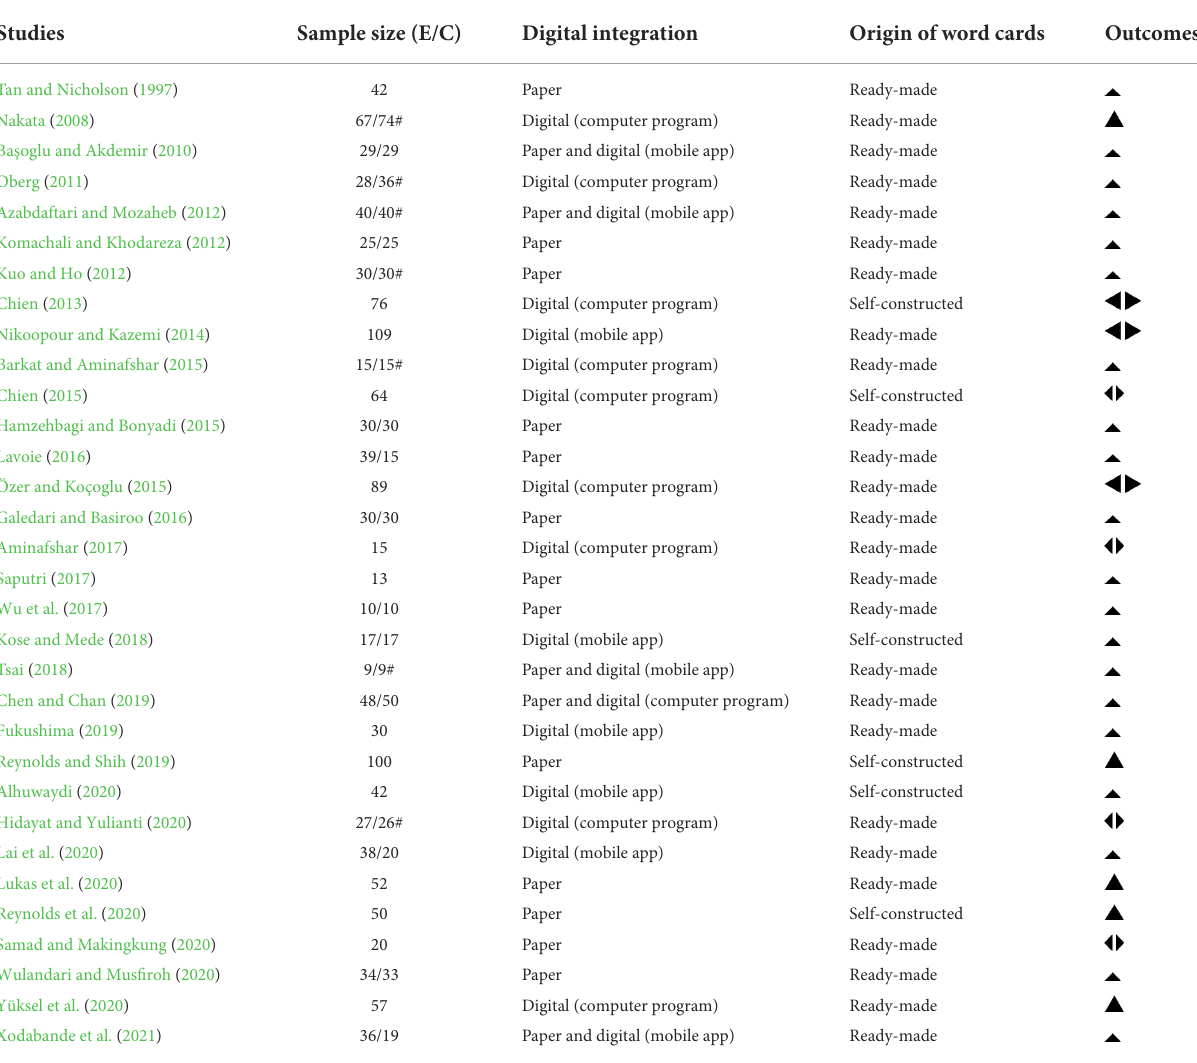
TABLE 5 Effect direction plot for type of word cards ( k =